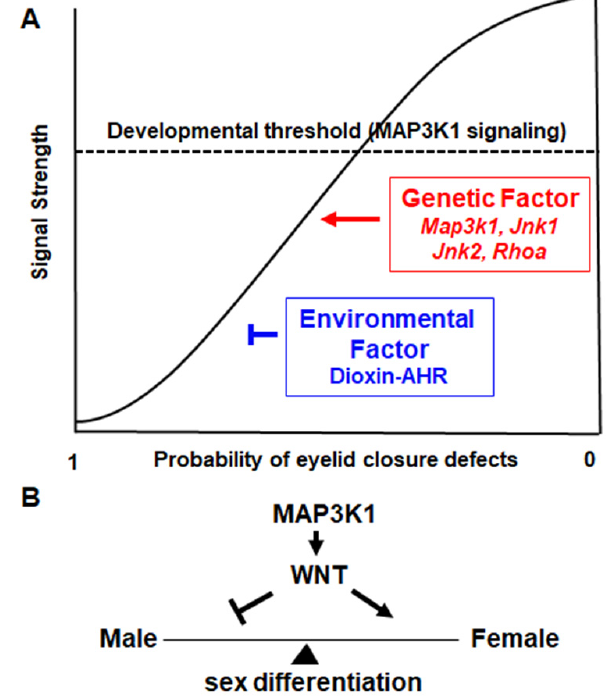
Figure 3. Summary and perspectives. ( A ) MAP3K1 signaling serves as a developmental threshold. Different genes and environmental factors distinctly affect the strength of MAP3K1 signaling; when the signaling strength reduces to levels below the critical threshold eyelid closure abnormalities occur. ( B ). The hypothetical roles of the MAP3K1–WNT axis in maintaining the balance of male–female sex differentiation.